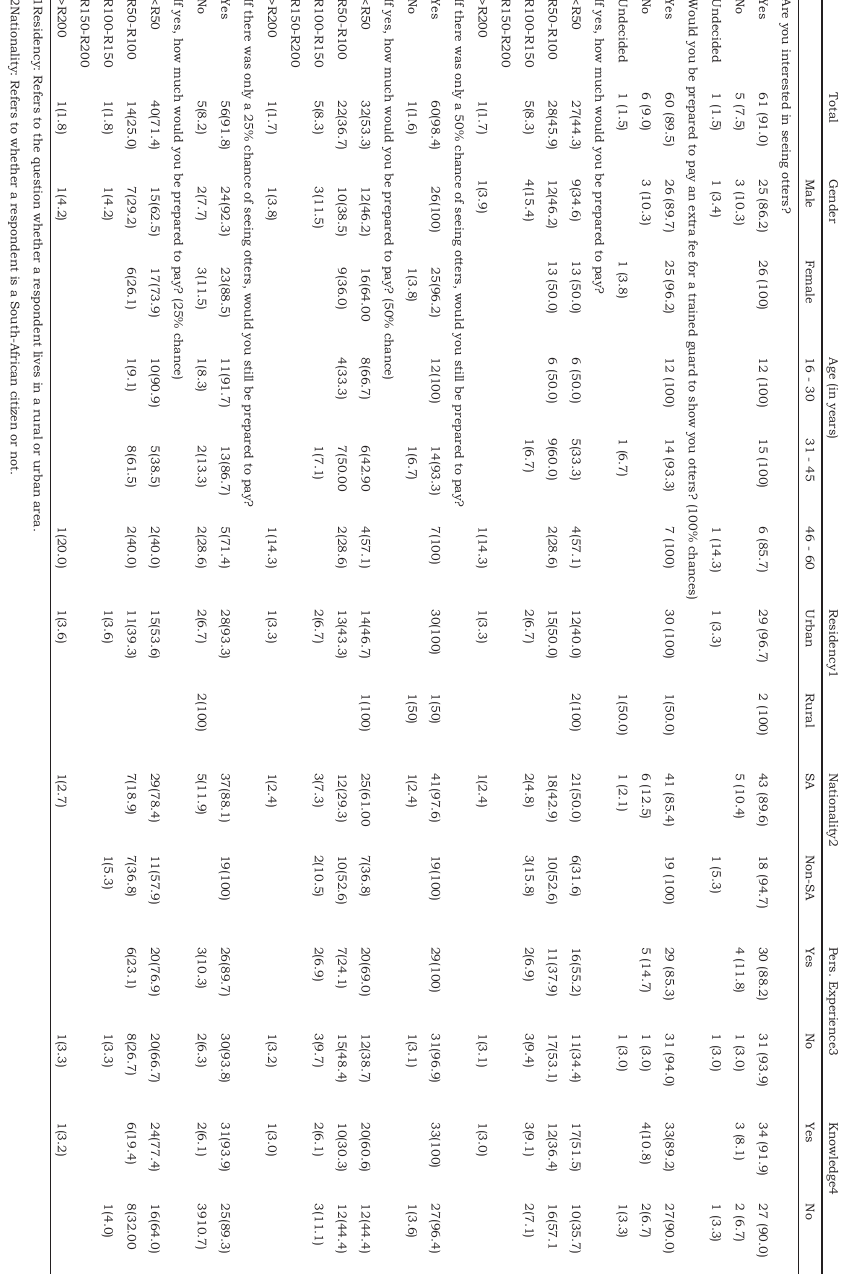
Table 1. Results of a questionnaire to determine willing to pay to view Cape clawless otters Aonyx capensis at Dwesa Nature Reserve. Values outside parentheses refer to number of respondents and val- ues inside parentheses refer to